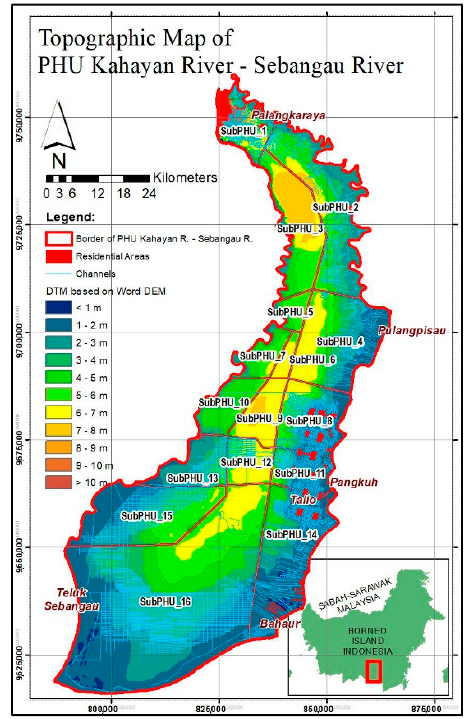
Figure 1. Overview of topographic condition on the Peat Hydrological Unit (PHU) area of Kahayan River–Sebangau River, complemented with channel networks and residential areas. The square red line shows the position of the PHU on the Borneo Island. (Data source: BRGM-RI). This PHU is a topographically flat area, and there are no steep and extreme topographical changes. The height difference from the shore area to the highest part (in Palangkaraya City) does not exceed 10 m. The shoreline and riversides are the lowest areas while the highest part is in the middle area, which is also the peat dome area of the PHU. This